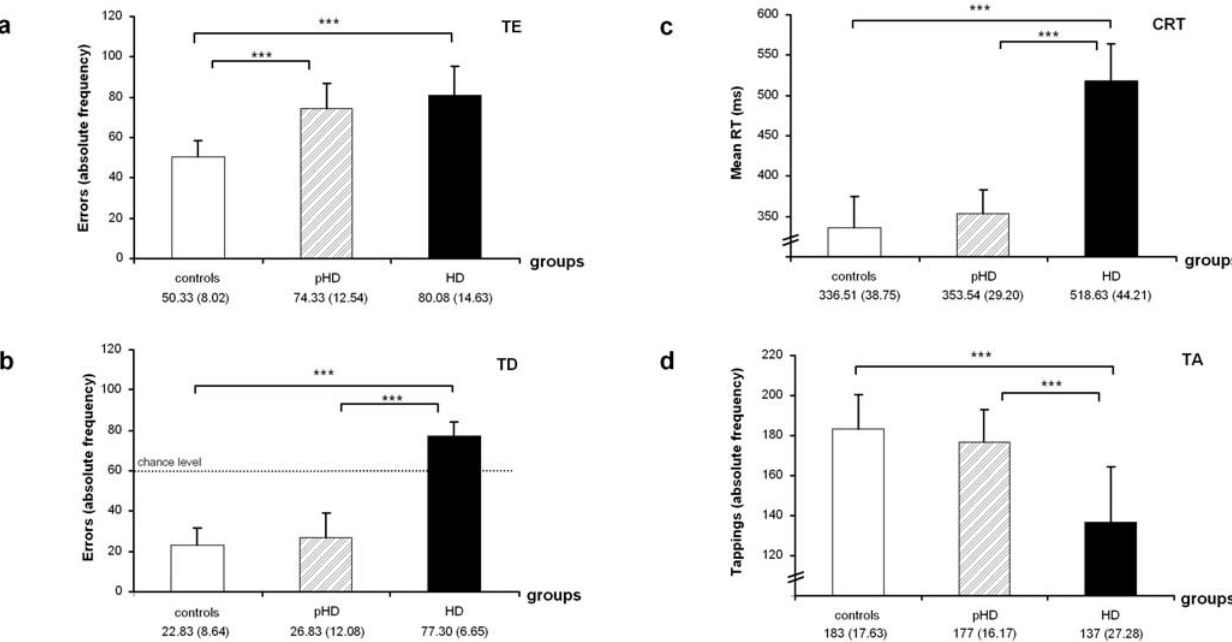
Figure 1. Performance on the TE (a), TD (b), CRT-task (c) and tapping (d). In (a) and (b) the absolute frequency of errors is given (note: In TD, performance differed from chance level), in (c) the mean reaction time, in (d) the number of taps are given, all with standard deviation